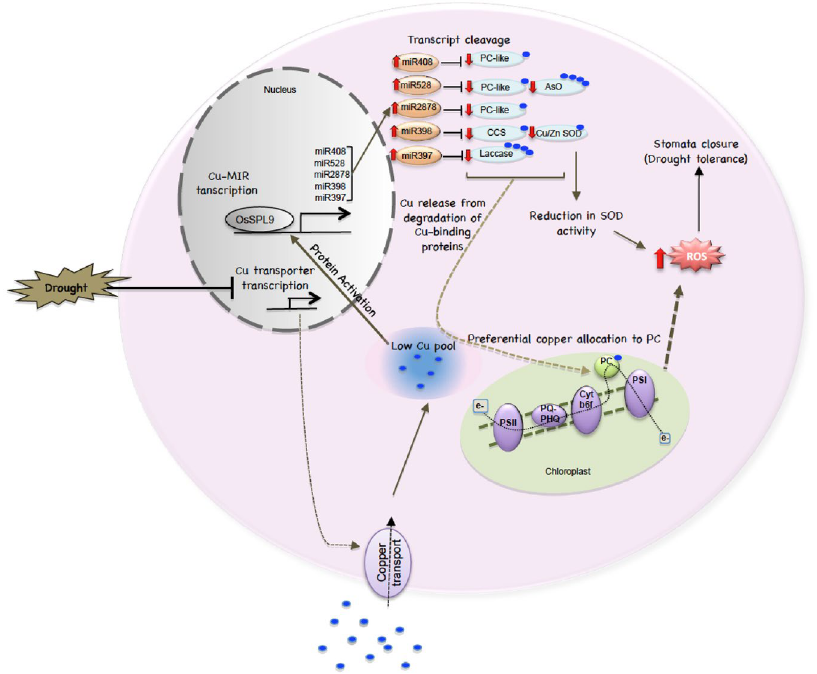
Figure 8. Model summarizing the cross-talk of copper and ROS homeostasis during drought in N22 flag leaf. In brief, during drought there is lowering of internal copper levels in the flag leaves of tolerant cultivar probably due to differential regulation of copper transporters. This leads to up-regulation of OsSPL9 and consequently of the CSDR-miRNAs. The CSDR-miRNAs then target several copper containing proteins such as plantacyanin and SODs. The observed stabilization of plastocyanin levels even during low cellular copper may indicate the role the ‘copper economy model’ involving the plantacyanins. On the other hand, down regulation of SODs lead to accumulation of ROS. High ROS levels may be responsible for the observed enhanced stomata closure in the tolerant